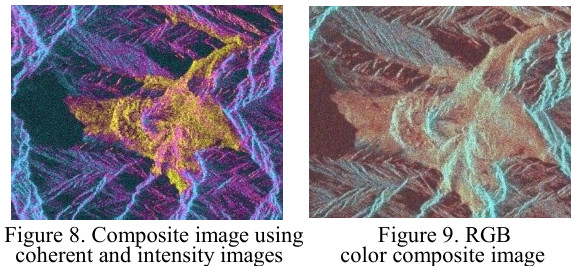
Figure 8. Composite image using Figure 9. RGB coherent and intensity images color composite